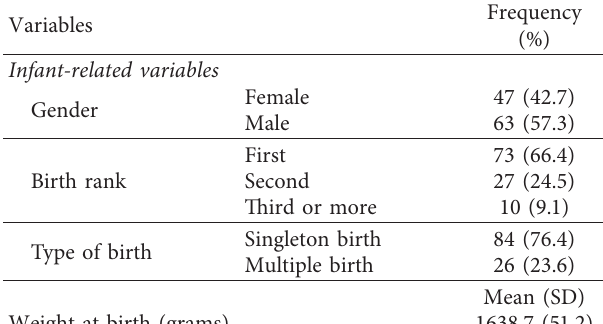
Table 1: The participants’ characteristics according to demo- graphic and social features ( n �